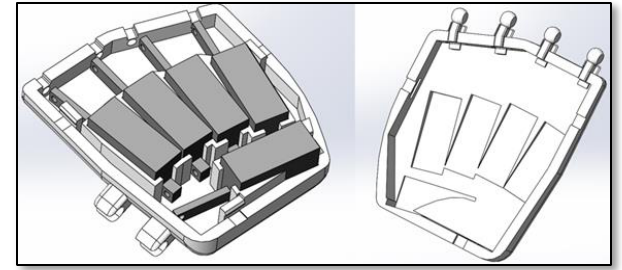
Figure 4. Actuators set-up within the palm.